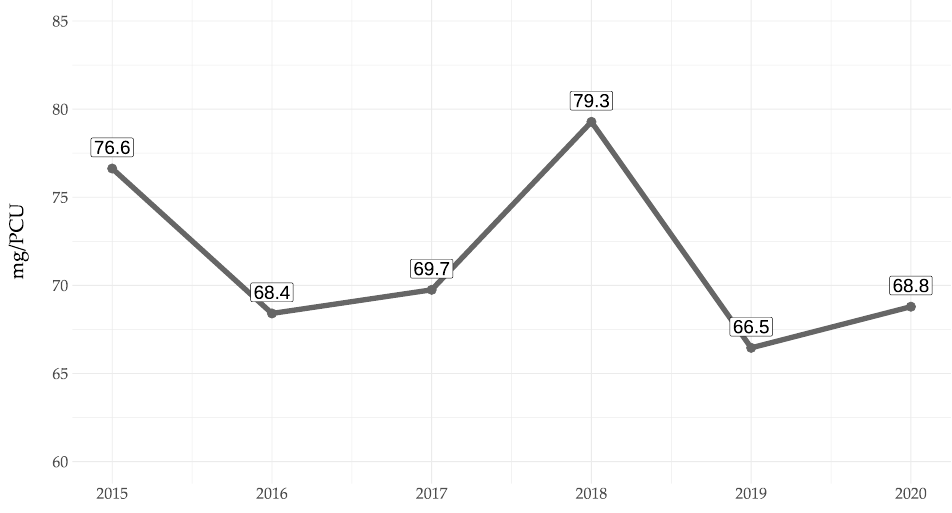
Figure 2. Amount of antimicrobials (mg/PCU) dispensed for use in pigs in Austria between 2015 and